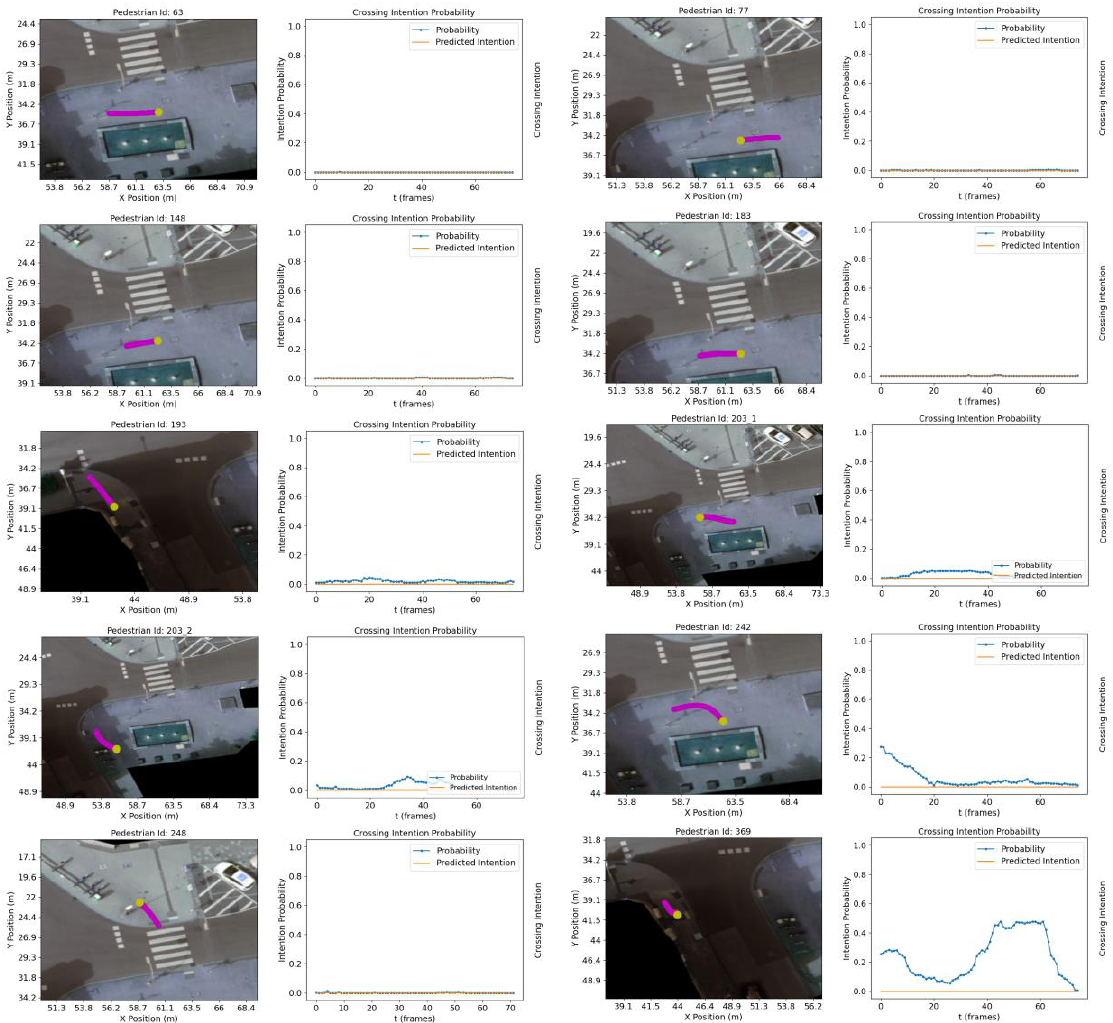
Figure 6. Classification results for 10 not crossing trajectories. Pedestrian trajectories are shown in magenta. The trajectory point shown in yellow indicates the last trajectory sample in the sequence.